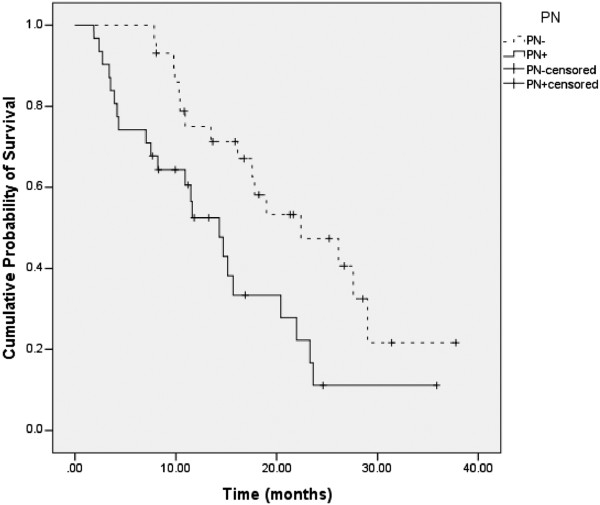
Survival stratified by 2 PN groups. Each drop in a probability curve indicates one or more events in that group. Vertical lines indicate censored patients, i.e., those who reached the end of their follow-up without experiencing death.